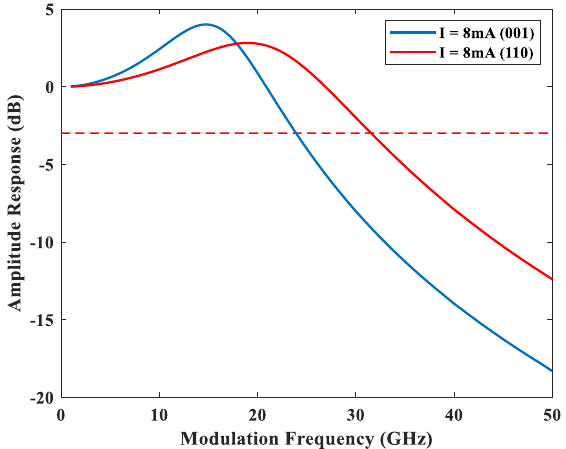
Figure 10. Small signal frequency response for (001) and (110) crystal orientations VCSELs.